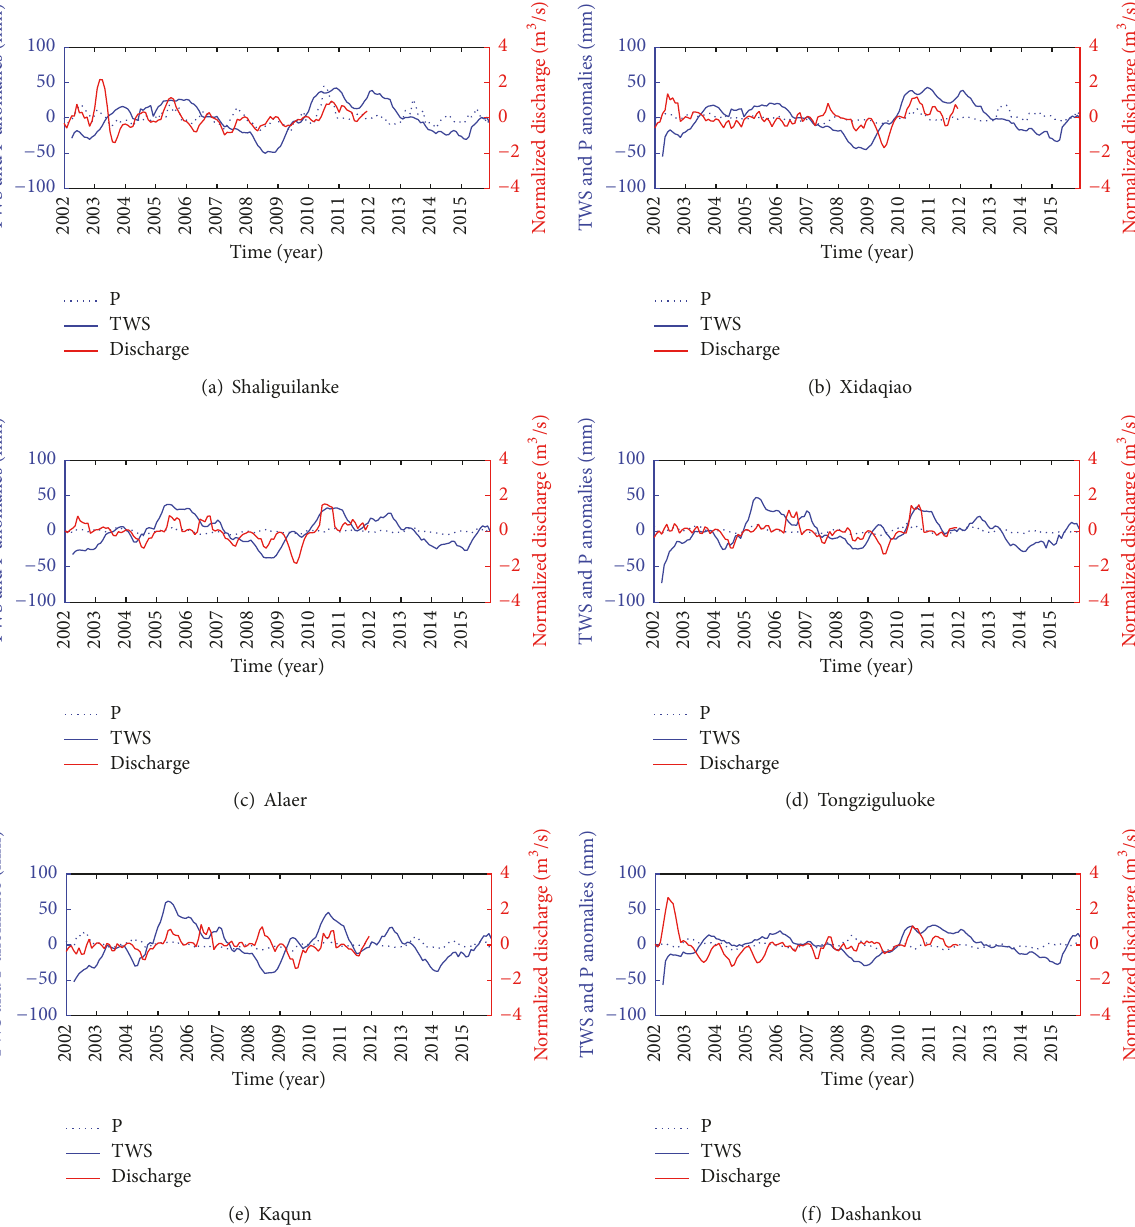
extremes in many regions [48]. Both the transport of water vapor and intensity of evaporation would be affected by the powerful atmospheric circulations; as a result, the conditions of TWS would be